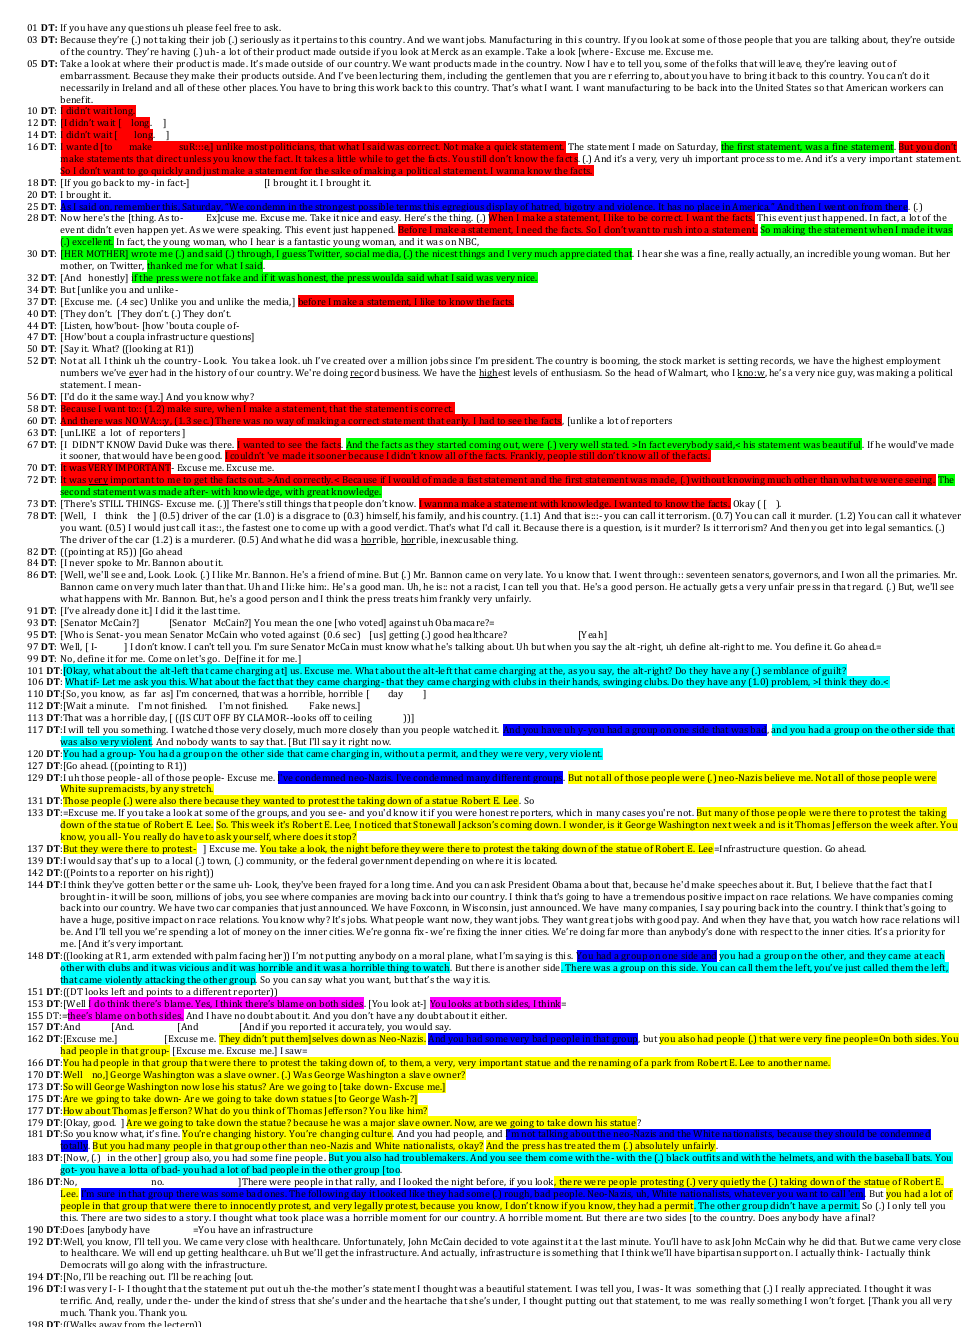
Figure 3. Trump’s major lines of argument (color coded) distributed over time. Dark blue : Nazis are bad, and I condemned them. Green : My statements were good. Red : I had to wait for the facts to make a full statement. Light blue : The alt-left was also violent and should be blamed. Purple : Both sides are to blame. Yellow : Some of the protestors were very fine people with legitimate reasons to protest that should not be condemned .